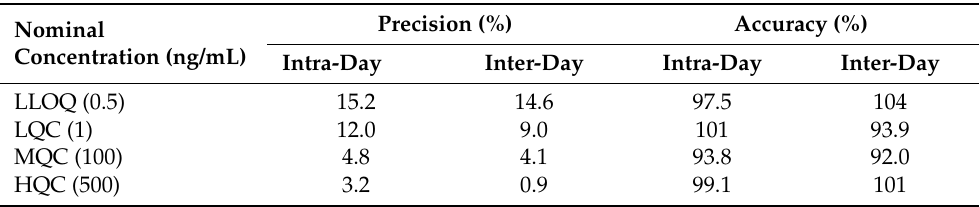
Table 1. Within-run and between-run precision and accuracy of the present bioanalytical method for the quantification of acacetin in rat plasma ( n =